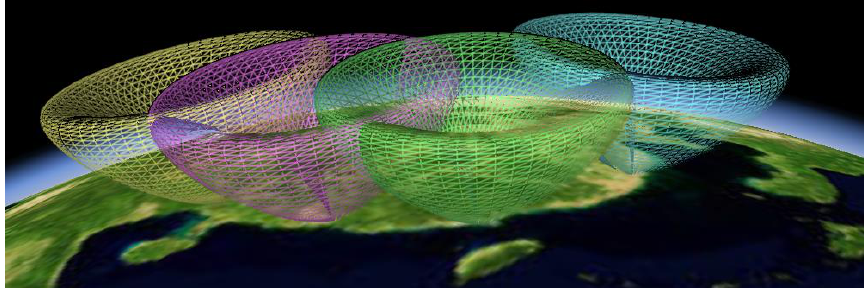
Figure 6. Visualization of the radar networking coverage on the virtual globe.